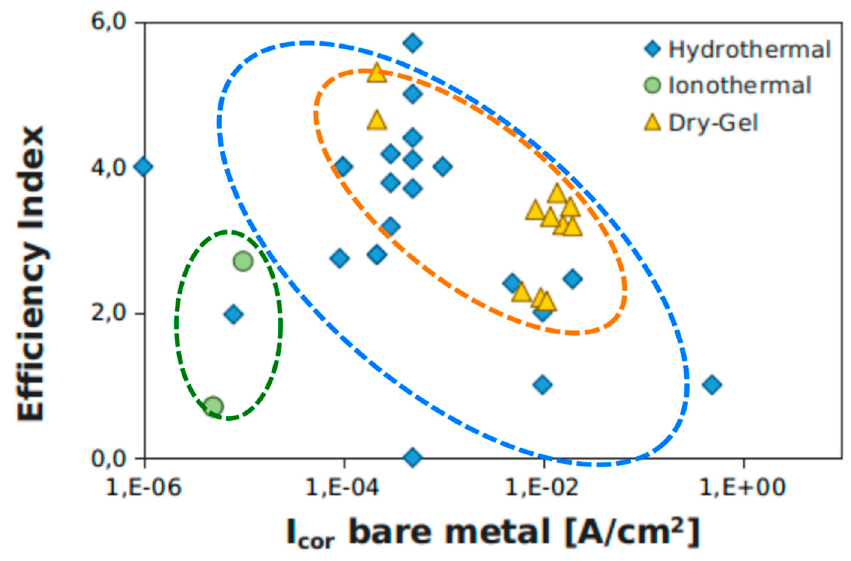
Figure 10. Efficiency index versus corrosion current of bare metal support.